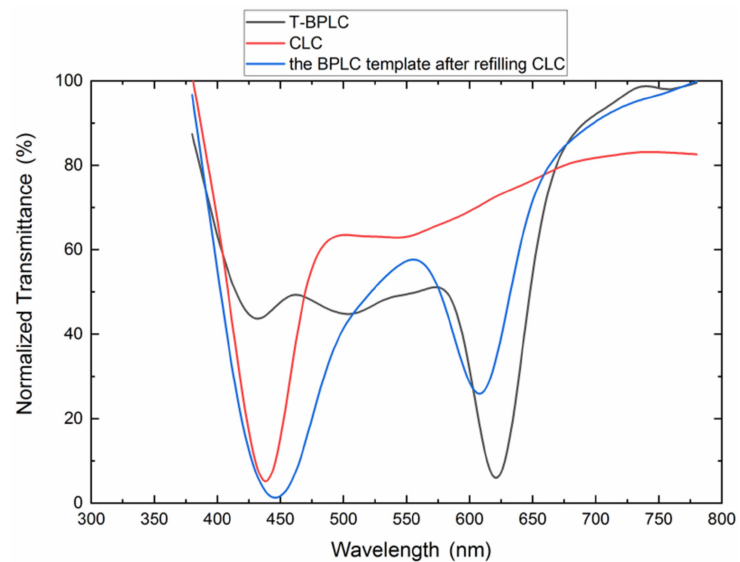
Figure 6. Transmittance spectra of T-BPLC, CLC, and dual-wavelength LC filter.